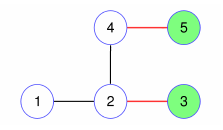
Figure 1: Graph with 5 vertices, colored nodes = V 1 , colored edges = E \ E ′ and h ( V 1 , V 2 ) = 1